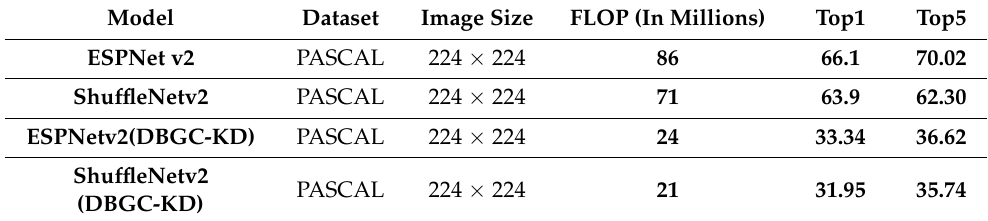
Table 5. Only depth-based kernel.